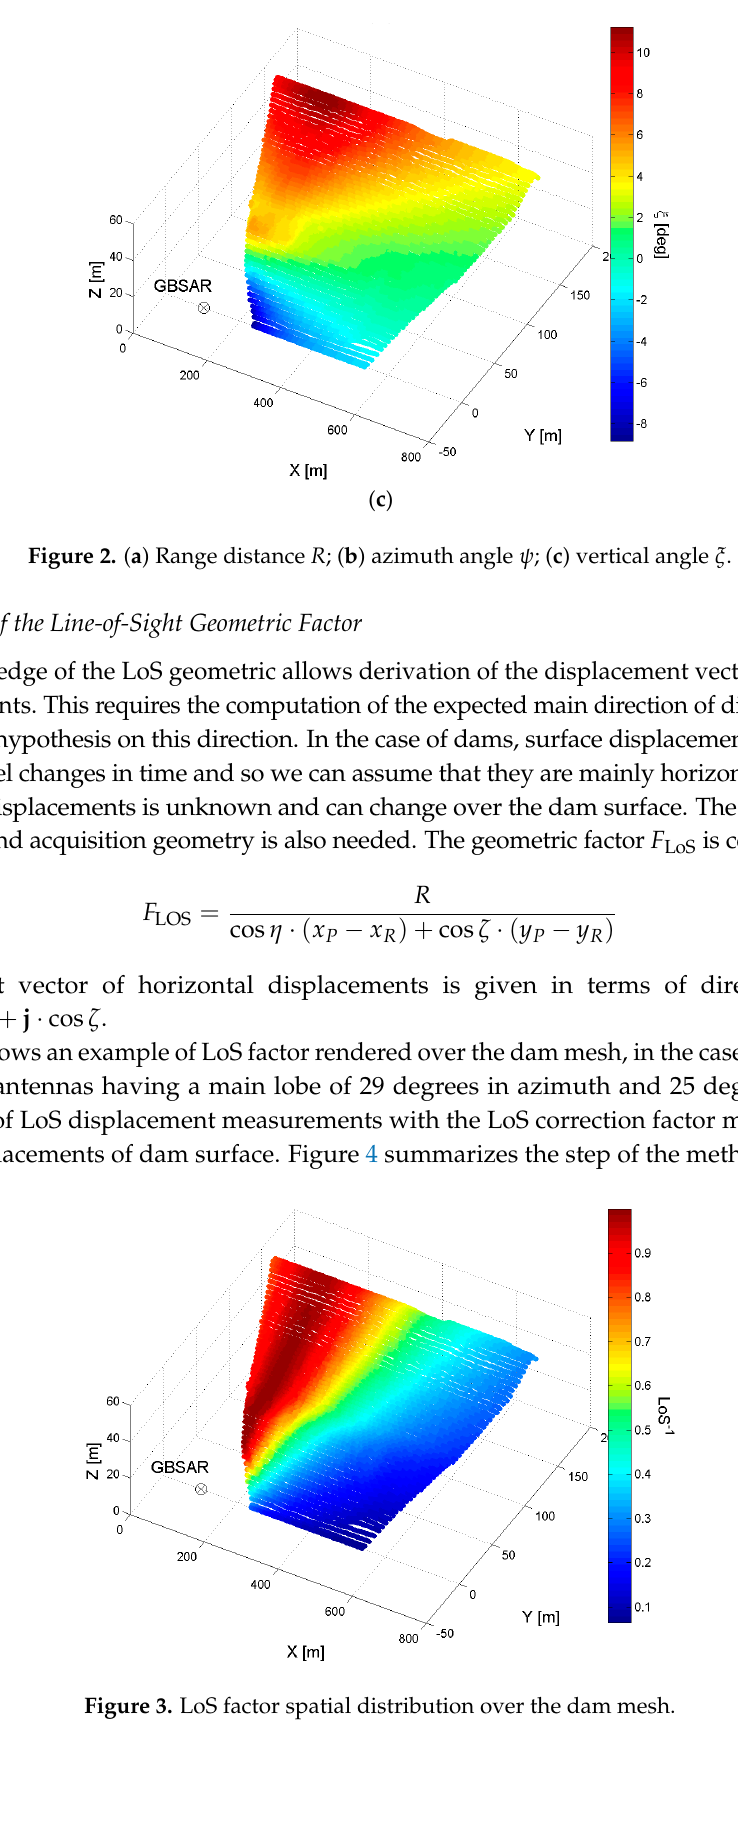
Figure 3. LoS factor spatial distribution over the dam